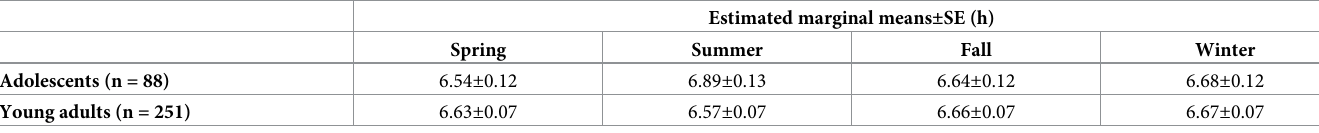
Table 7. Sleep duration for each season in the adolescents and young